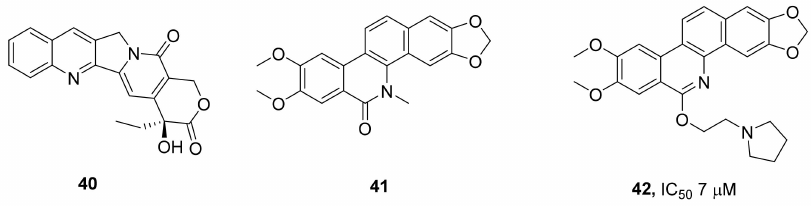
Figure 12. Camptothecin and its analogs that are potential TDP1